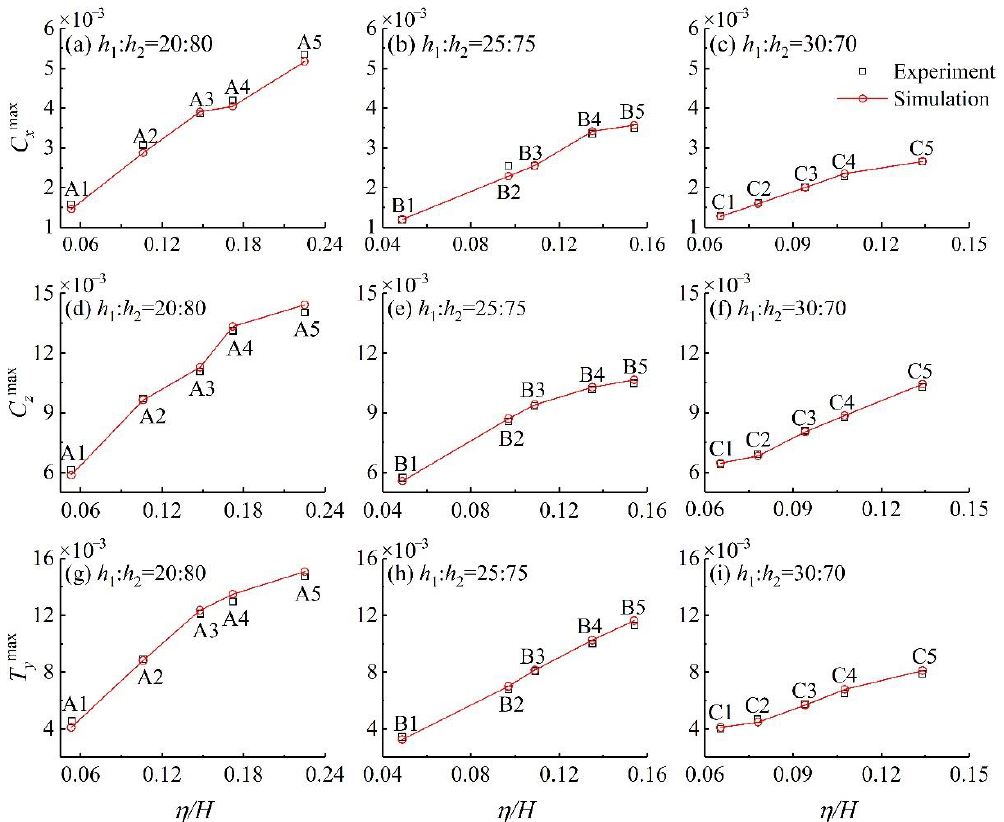
Figure 4. The comparison of forces and torques coefficients on the semi-submersible platform between experiment data and numerical simulation results. η is the wave amplitude.